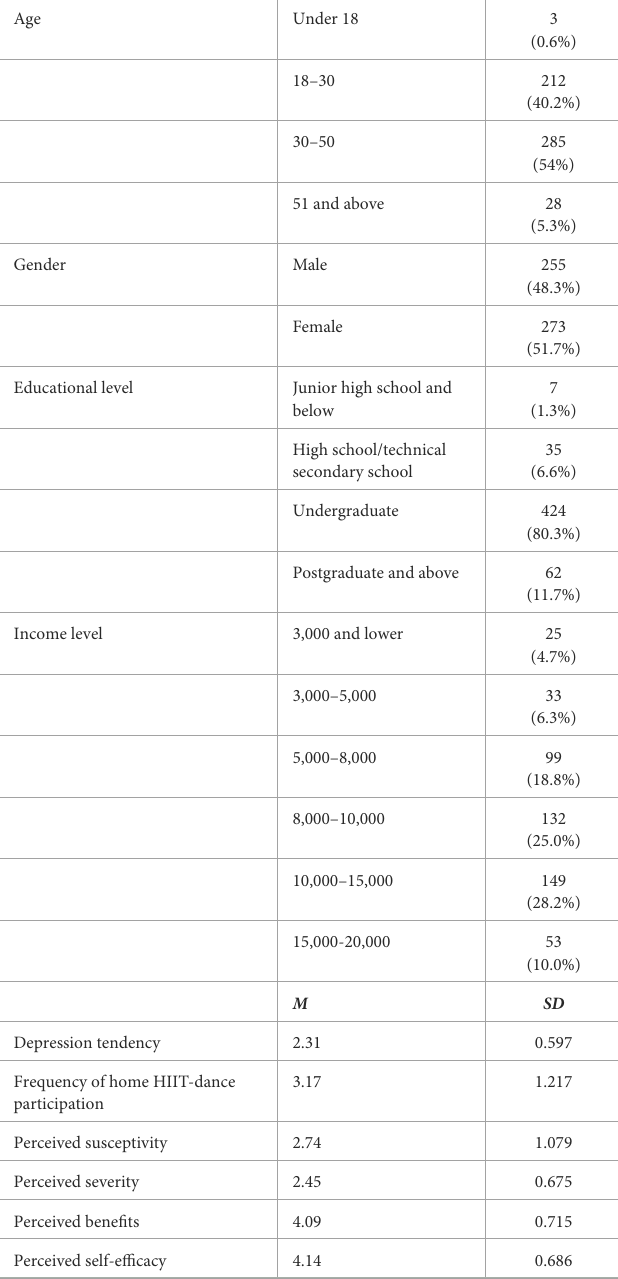
TABLE 1 Basic characteristics of respondents. TABLE 2 Hierarchical regression results of associated factors with